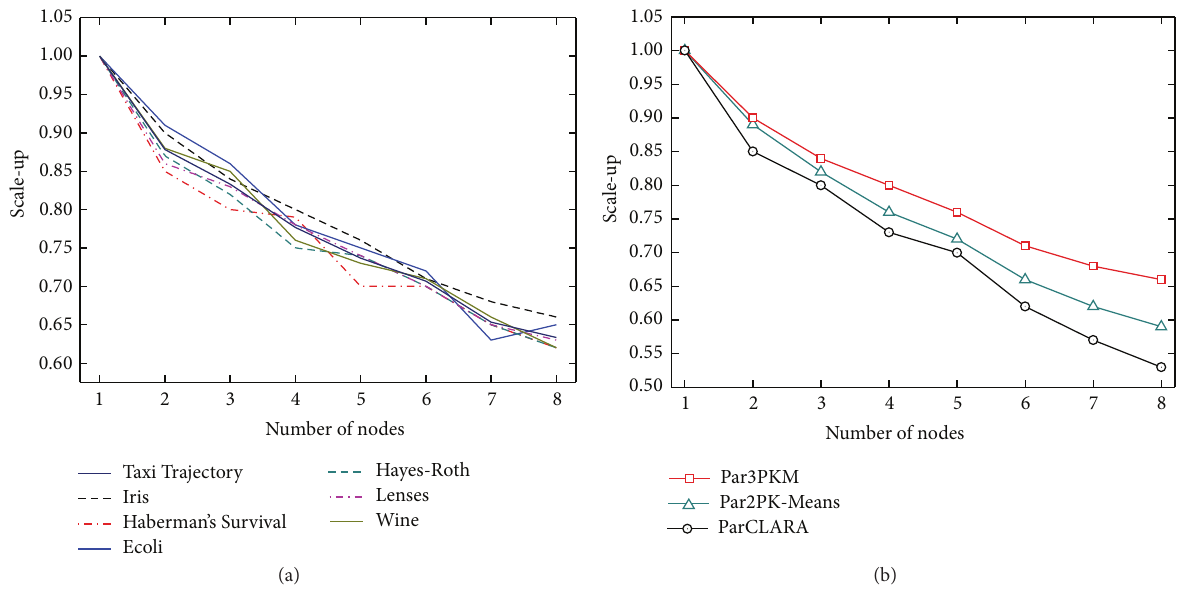
Figure 14: Scale-up. (a) Scale-up comparison of Par3PKM on different data sets and (b) scale-up comparison of Par3PKM, Par2PK-Means, and